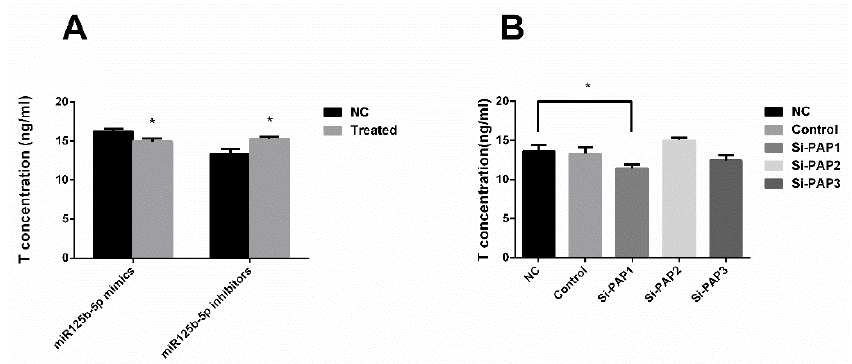
Figure 5. MiR-125b-5p and PAP affected TM3 cell secreted testosterone. ( A ) TM3 cells were transfected with miR-125b-5p mimics/NC/inhibitor/iNC. ( B ) TM3 cells were transfected with different kinds of PAP siRNAs. The T (testosterone) concentration of the cell supernatants were determined ( n = 6). All of the data are expressed as mean ± SEM. * p < 0.05.